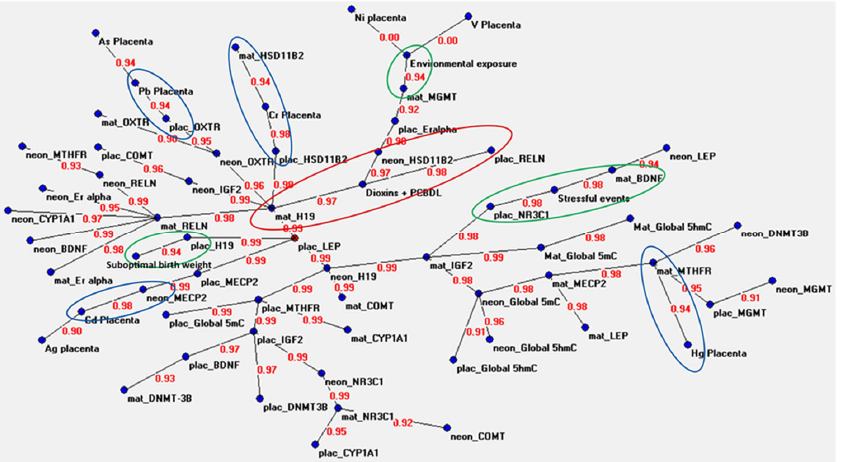
Figure 1. Semantic connectivity map obtained with the auto-contractive map system. The values between two variables correspond to the strength of the associations between them. These values range from 0 (which means that the variables are not connected) to 1 (which means that the variables are highly connected). The green circles indicate relevant connections between DNA methylation and questionnaire data. The blue circles indicate relevant connections between DNA methylation data and metals in the placenta. The red circle indicates relevant connections between DNA methylation data and dioxins/PCBs in the placenta.